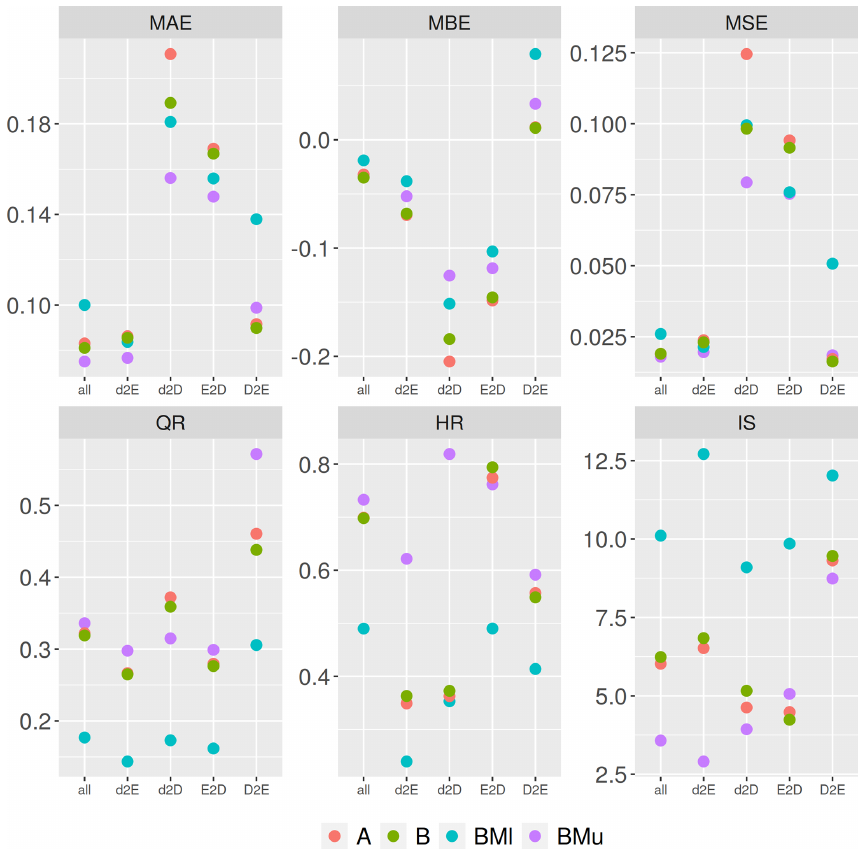
Figure 7. Model performance metrics in regional transfer. Models A and B based on spatial numerical measures calculated for OSM building footprints; benchmark models BMl and BMu based on CATI survey data. Transfer experiments d2E, d2D, E2D and D2E as described in Table 3; “all” refers to using all records from all regions; cf. Table